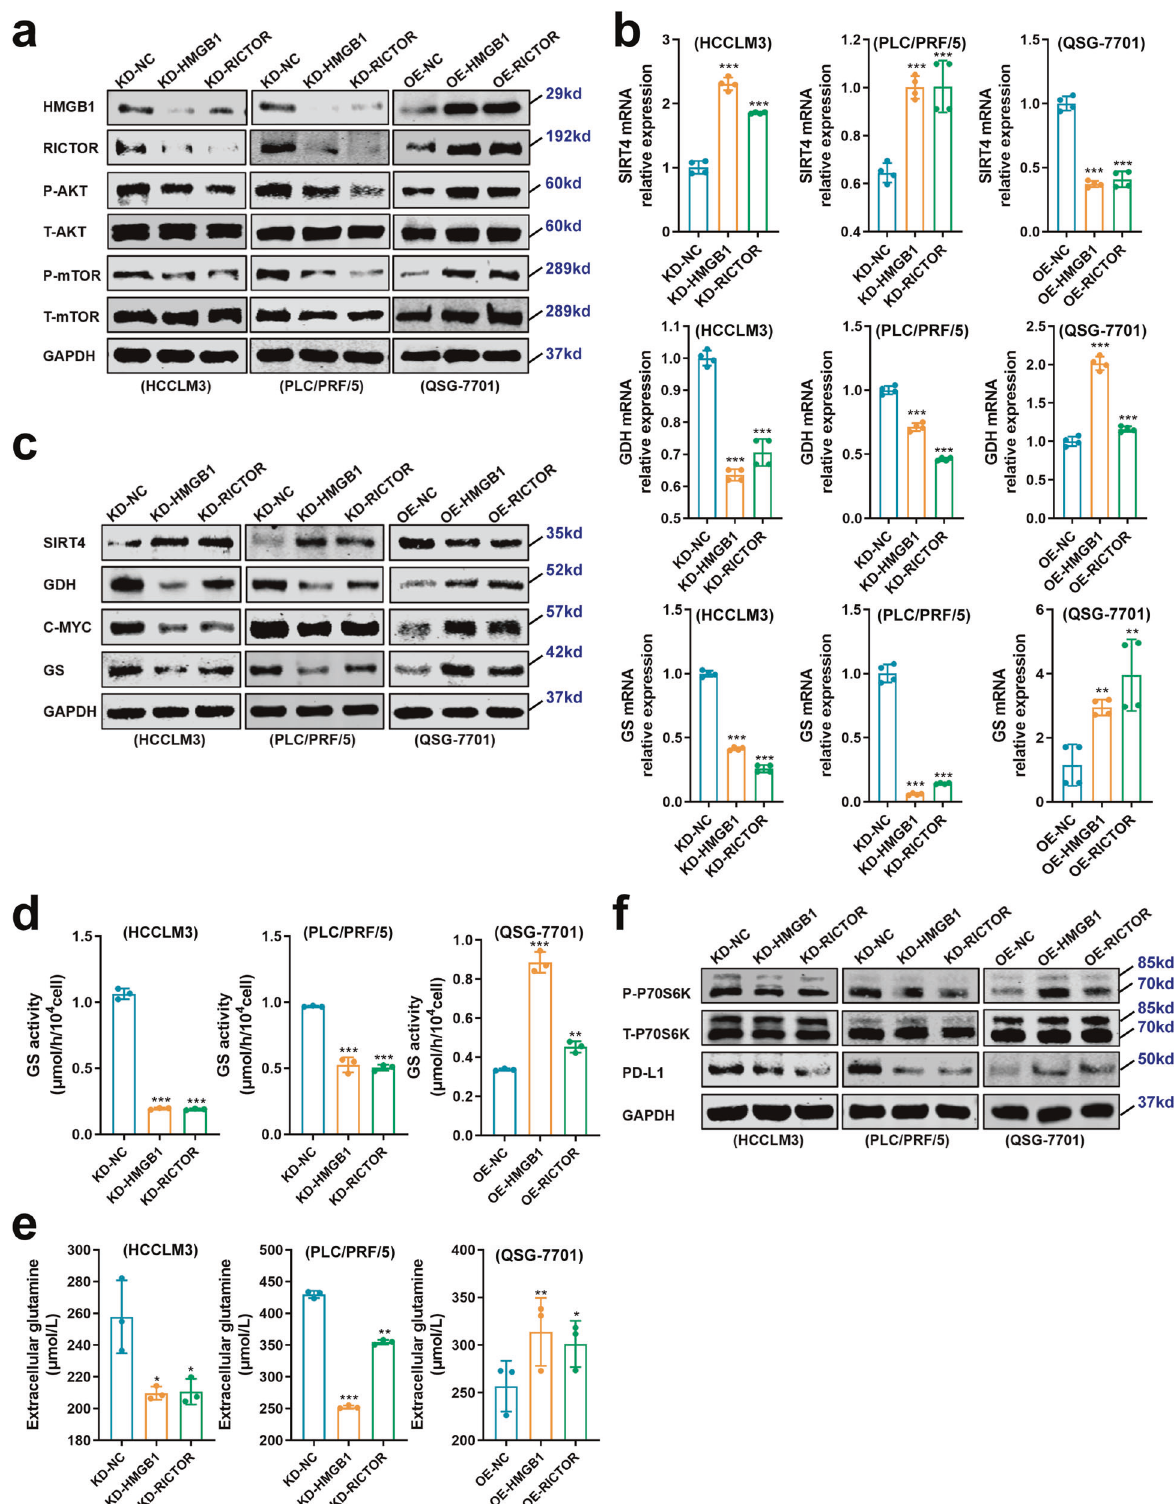
Fig. 6 Glutamine metabolism and PD-L1 expression are regulated by the HMGB1 – RICTOR epigenetic crosstalk effects on the mTOR pathway. a Western blot showing the levels of AKT and mTOR phosphorylation in treated HCC cell lines. b , c mRNA ( b ) and protein ( c ) levels of enzymes related to glutamine metabolism were determined by qRT-PCR and Western blot, respectively. ** p < 0.01, *** p < 0.001. d GS activity was measured using a colorimetric kit in indicated HCC cells. ** p < 0.01, *** p < 0.001. e Glutamine concentrations in cell culture supernatants from treated HCC cells were determined. * p < 0.05, ** p < 0.01, *** p < 0.001. f Western blot analysis comparing P70S6K and PD-L1 levels in the indicated HCC